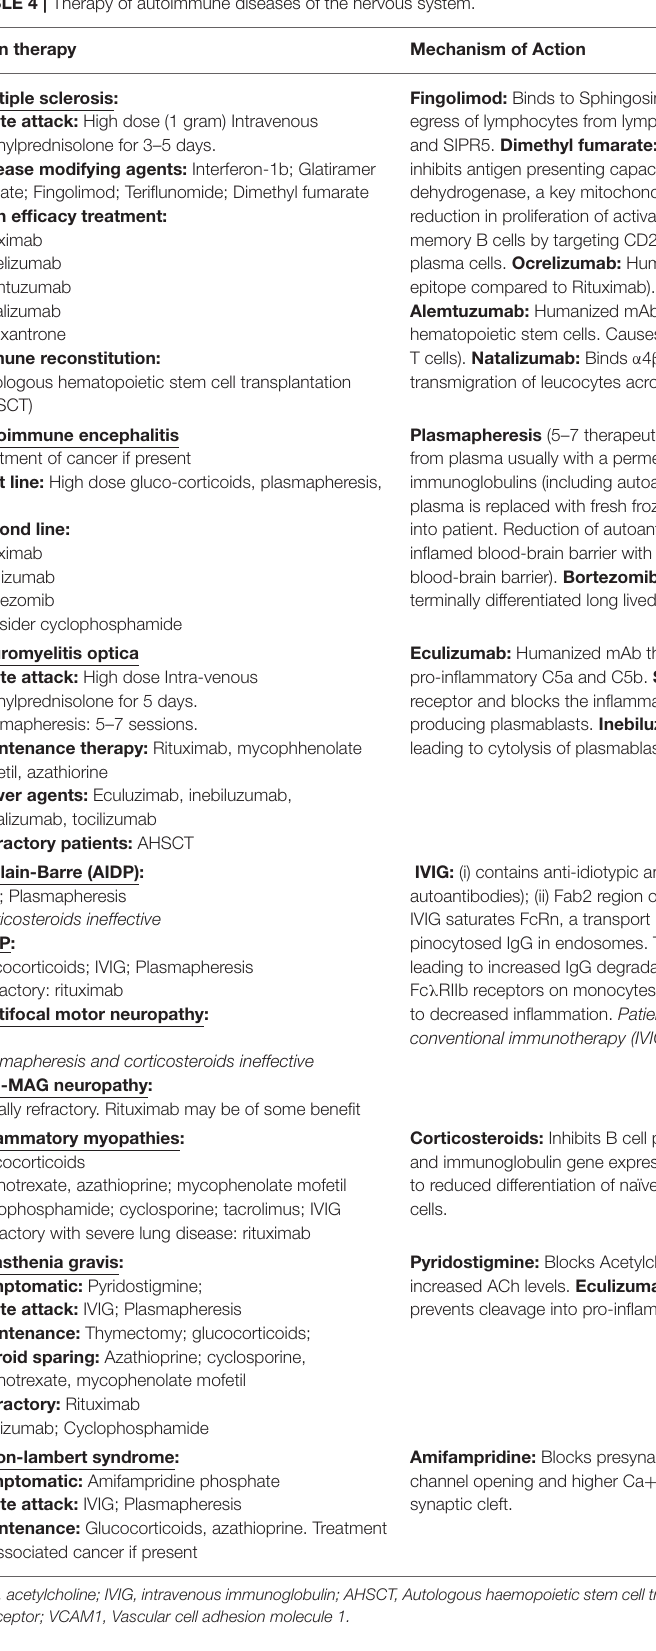
TABLE 4 | Therapy of autoimmune diseases of the nervous